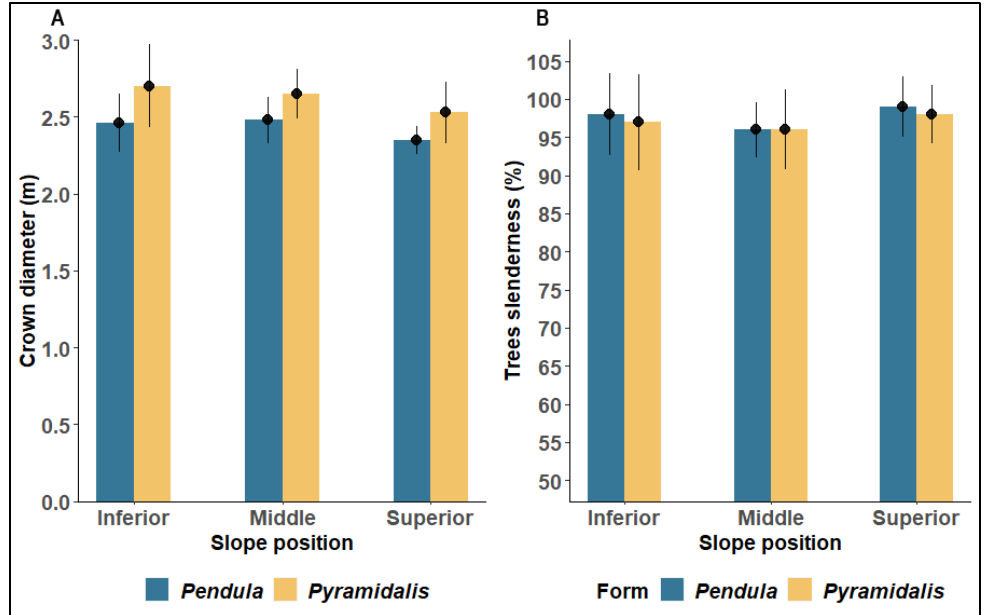
Figure 11. Variation in the stability traits: crown diameter ( A ) and tree slenderness ( B ) by the slope position. The black vertical lines represent the standard deviation.